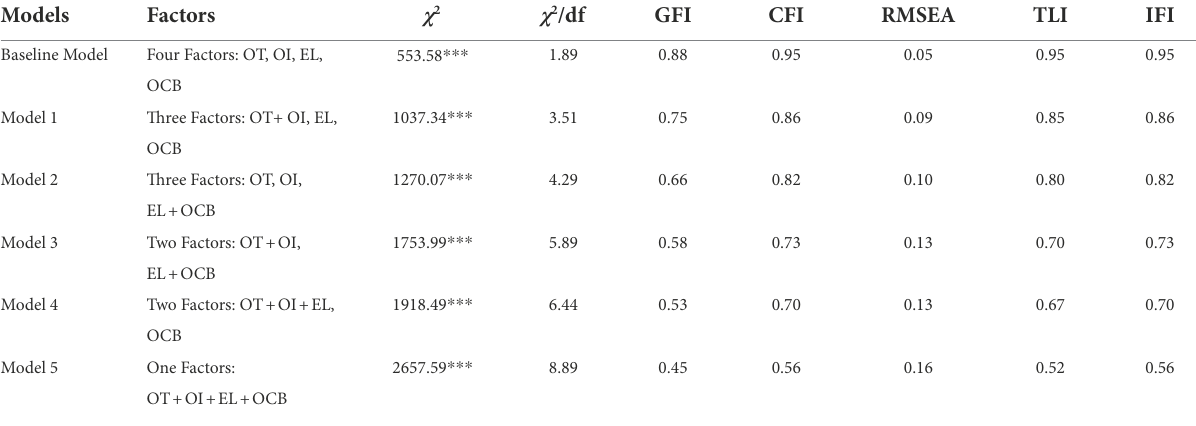
TABLE 2 Comparison of measurement model. Models